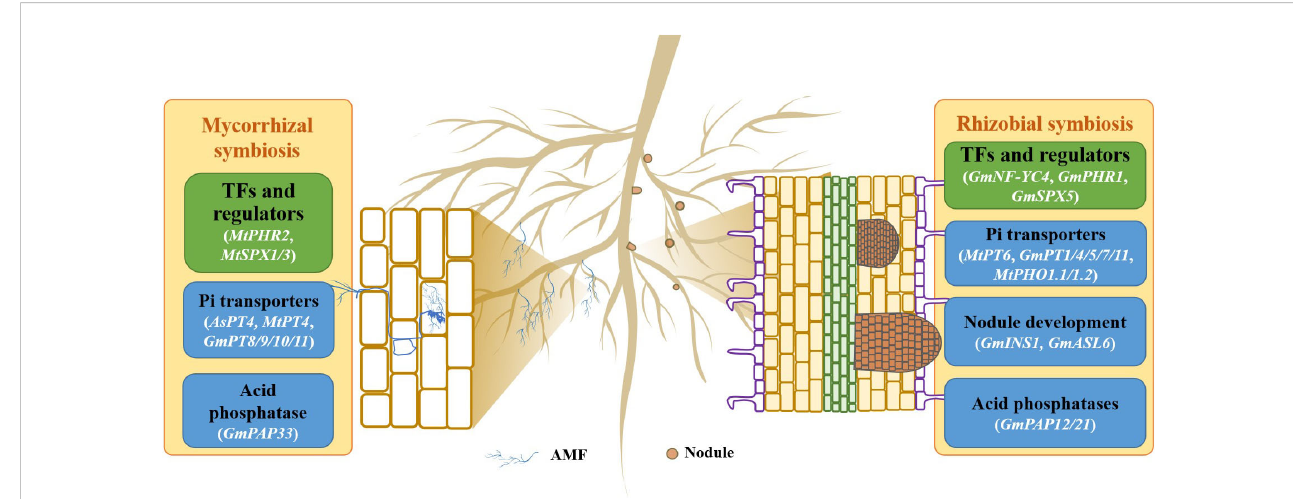
FIGURE 2 Genes involved in symbiotic interactions in the response of legumes to P de fi ciency. A model for mycorrhizal and rhizobial symbioses is presented. AMF, arbuscular mycorrhizal